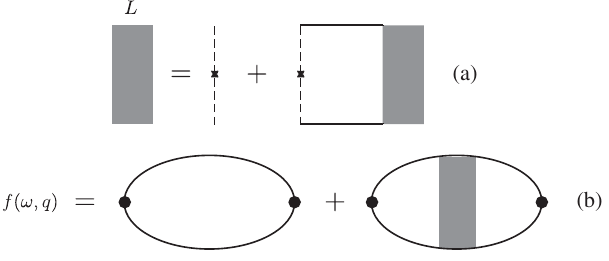
FIG. 3. (a) Resummation of disorder rungs. (b) Relation between L ð ω ; q Þ and f ð ω ; q Þ .